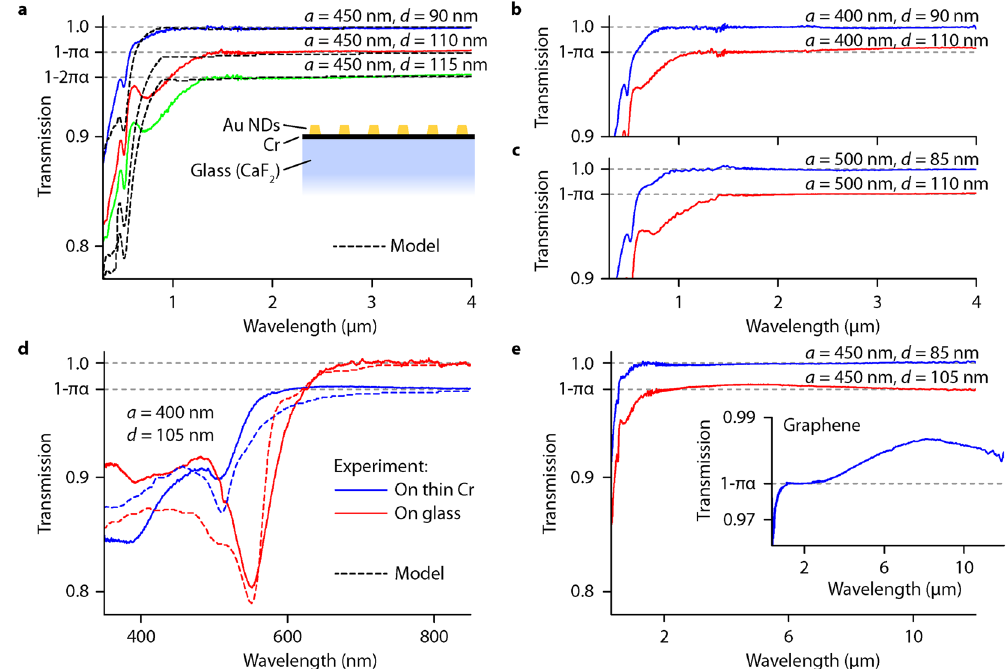
Figure 3. Relative optical transmission spectra of Au ND arrays. ( a – c ) Relative transmission spectra measured for different ND sizes and a lattice period, solid lines. The dashed lines in ( a ) show the modelling results for these ND arrays. The inset in ( a ) provides the schematics of samples. ( d ) Suppression of plasmon resonances of arrays fabricated on conductive Cr substrate, solid blue line, and restoration of plasmon resonances after etching the Cr sublayer, solid red line. The dashed lines show the results of modelling. ( e ) The relative transmission spectra for the plasmonic nanoarrays fabricated on a CaF 2 substrate measured to the mid-infrared region. Inset shows measured transmission spectrum of a monolayer, exfoliated graphene